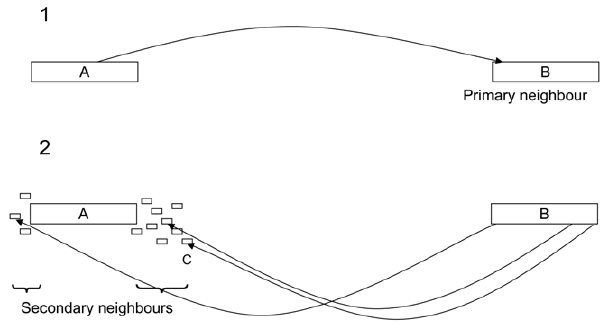
Figure 1. Construction of the secondary scaffold. From a unique node A, Pebble starts by incorporating all the distances relative to this node found in the primary scaffold. For every unique node B which is connected to A, Pebble then follows the primary connections associated to B, thus flagging secondary neighbours of A. Assuming that all the nodes are laid out on a line, we can estimate that the distance from A to C is equal to the distance from A to B, minus that from B to